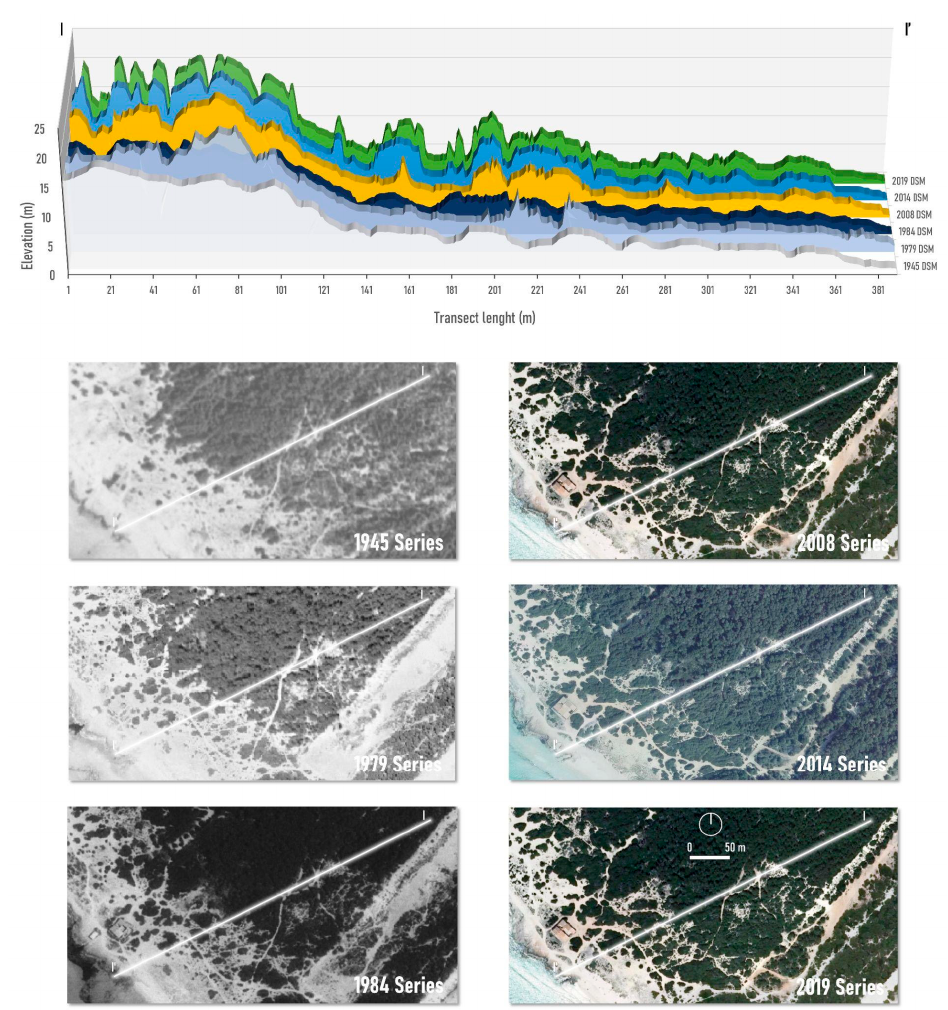
Figure 10. Transect comparison among the generated DSM series and corresponding overview in the historical orthomosaics.